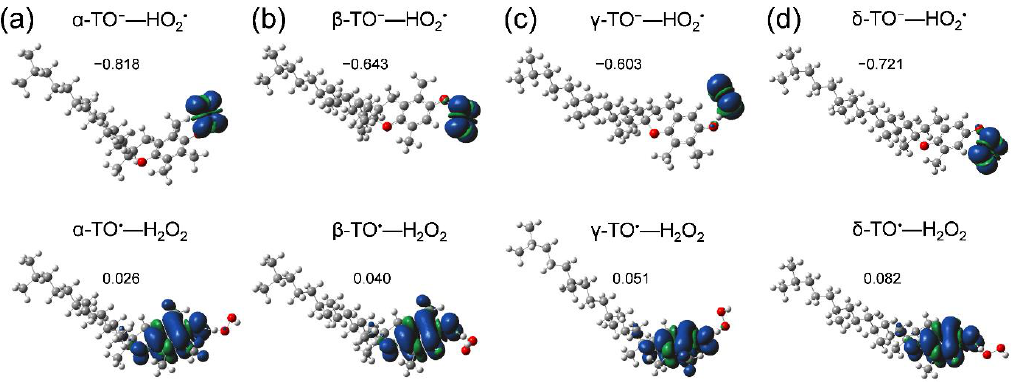
Figure 6. Optimized structure and spin distribution of HB complexes of α -, β -, γ -, and δ -TOH ( a – d );